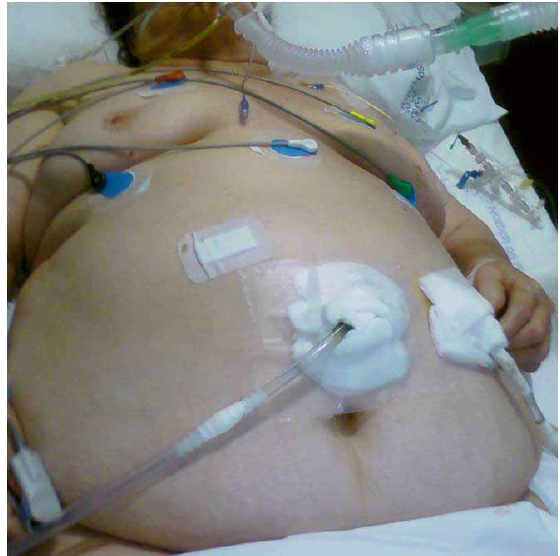
Figure 3. 82 years-old woman operated because of early infected pancreatic necrosis by laparoscopic transperitoneal ap- proach (3 ports) in our institution. After removing necrotic tissue, a system of drains is placed through the ports for continuous postoperative